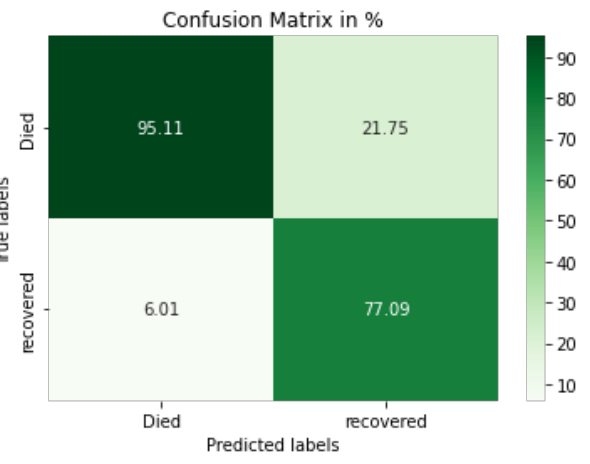
Figure 11. Confusion matrix for the proposed CV-CNN model. Table 6. Results of the CV-CNN proposed model using different evaluation metrics based on a 10-fold cross-validation.